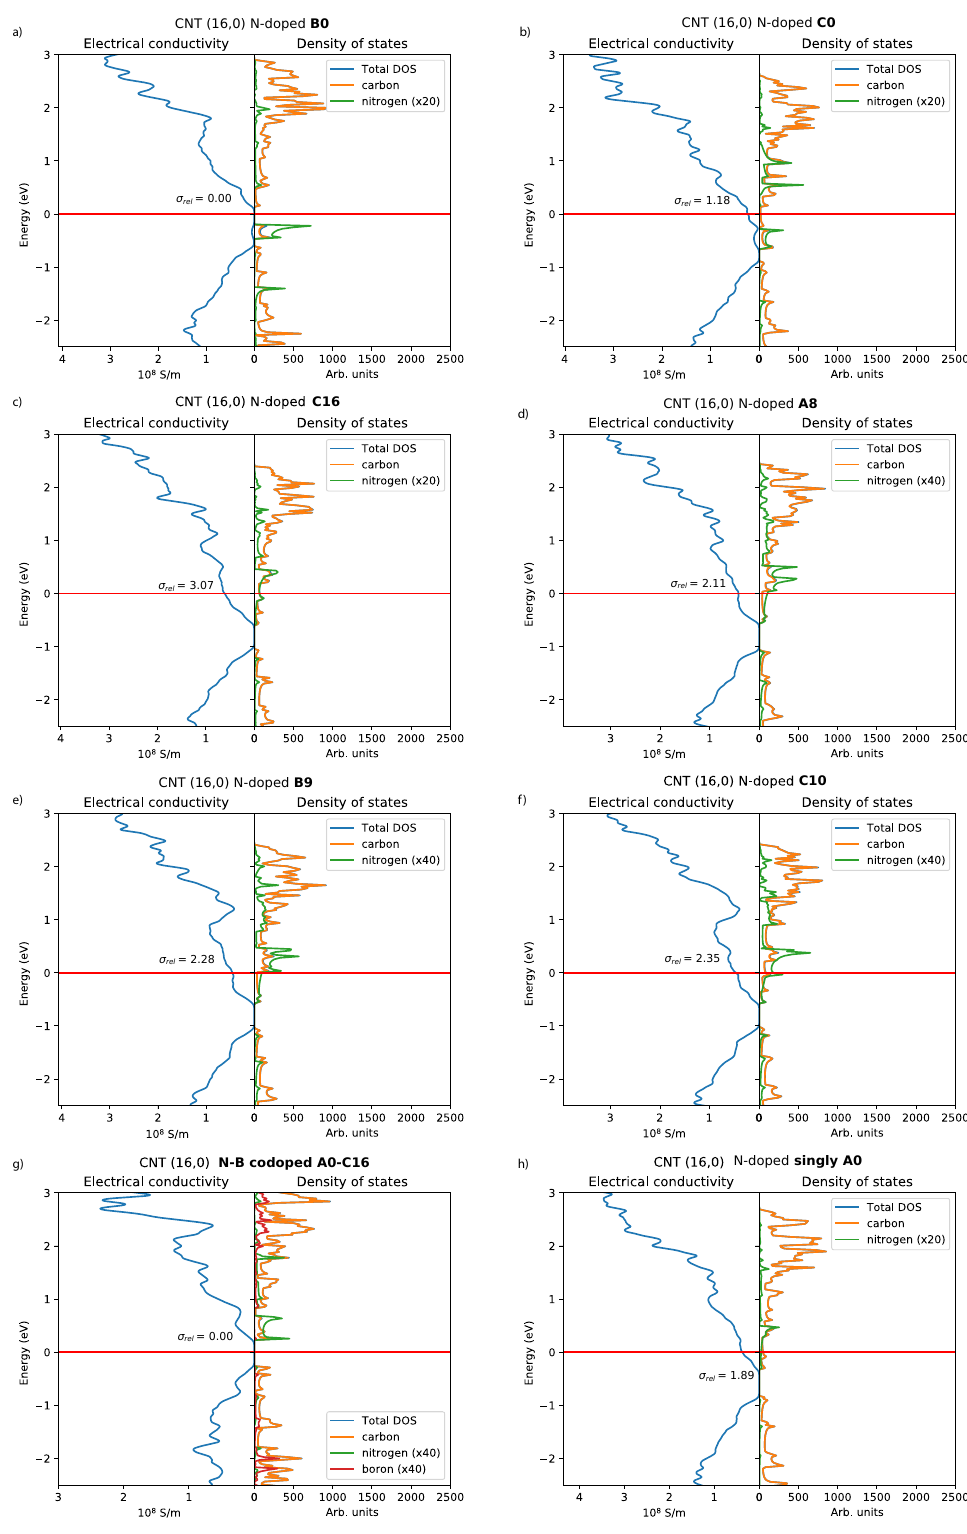
Figure 2. Electrical conductivities and densities of states of the studied N-CNT systems ( a – f ), B–N- codoped system ( g ), and single N-dopant system ( h ). Constant relaxation time τ = 1 fs was used for all systems, and only the relative magnitudes of the electrical conductivities between N-CNTs should be compared. For naming, see Figure